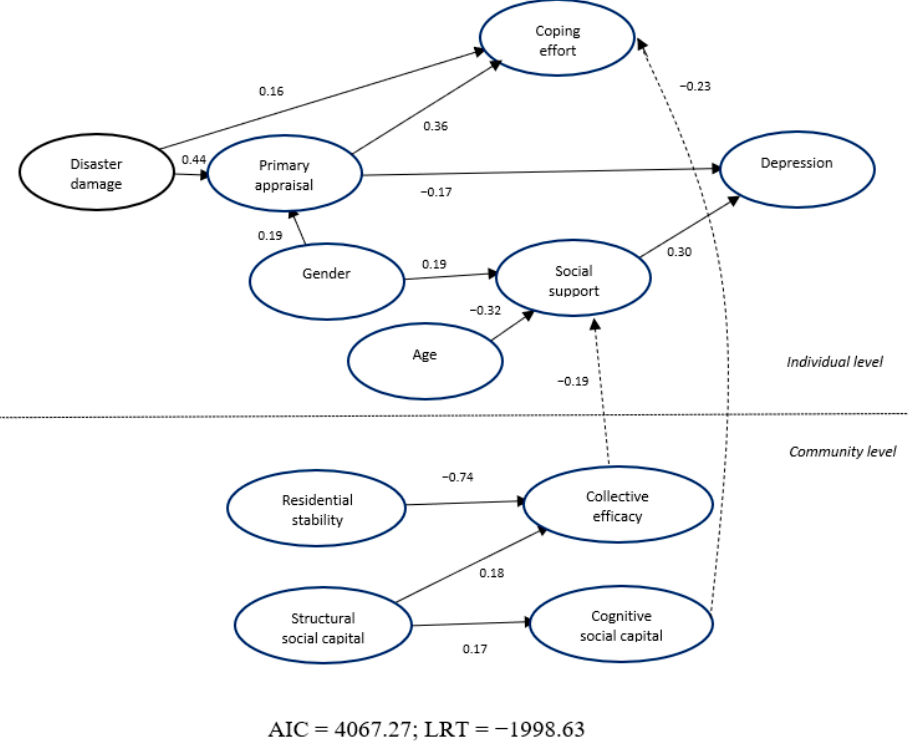
Figure 1. The multilevel structural equation model.